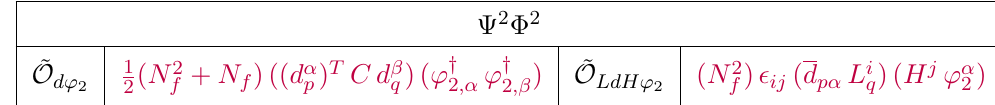
Table 36 . SM extended by Lepto Quark ( ϕ 2 ): additional operators of dimension 5. Here i, j and α, β are the SU(2) and SU(3) indices respectively. p, q = 1 , 2 , · · · , N f are the flavour indices. Both operators violate lepton